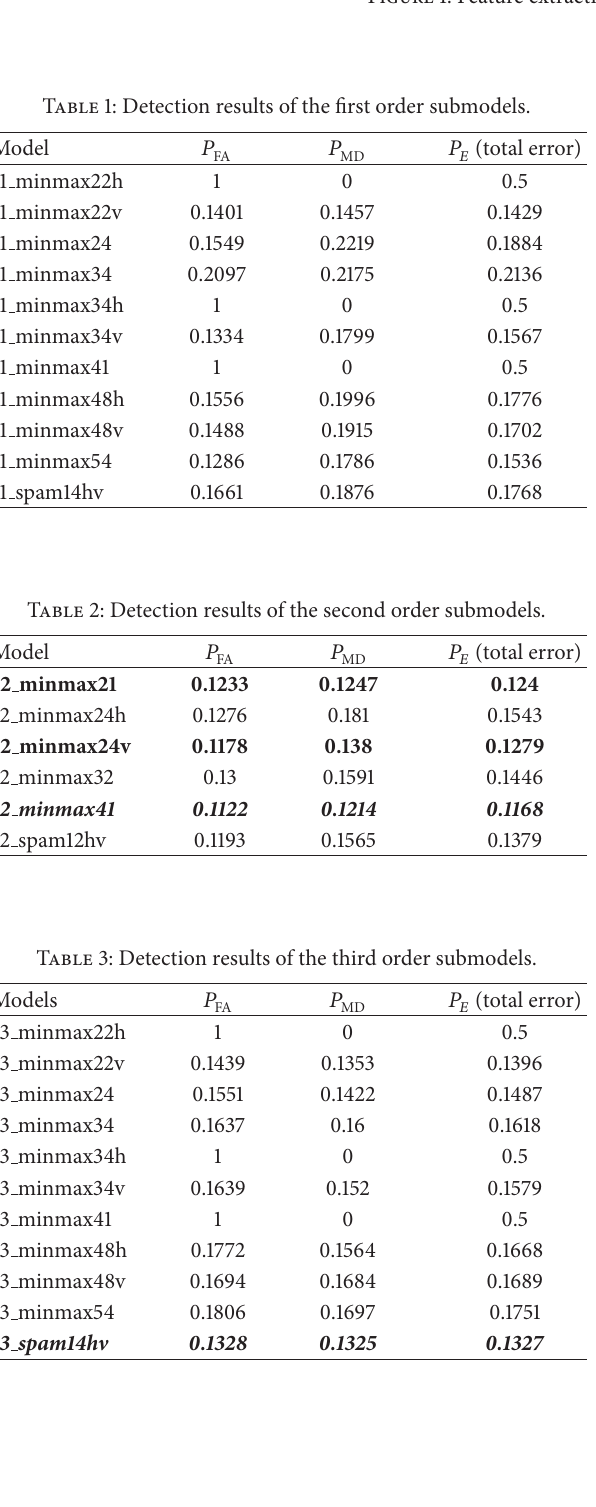
Figure 1: Feature extraction in DCT of Chrominance.